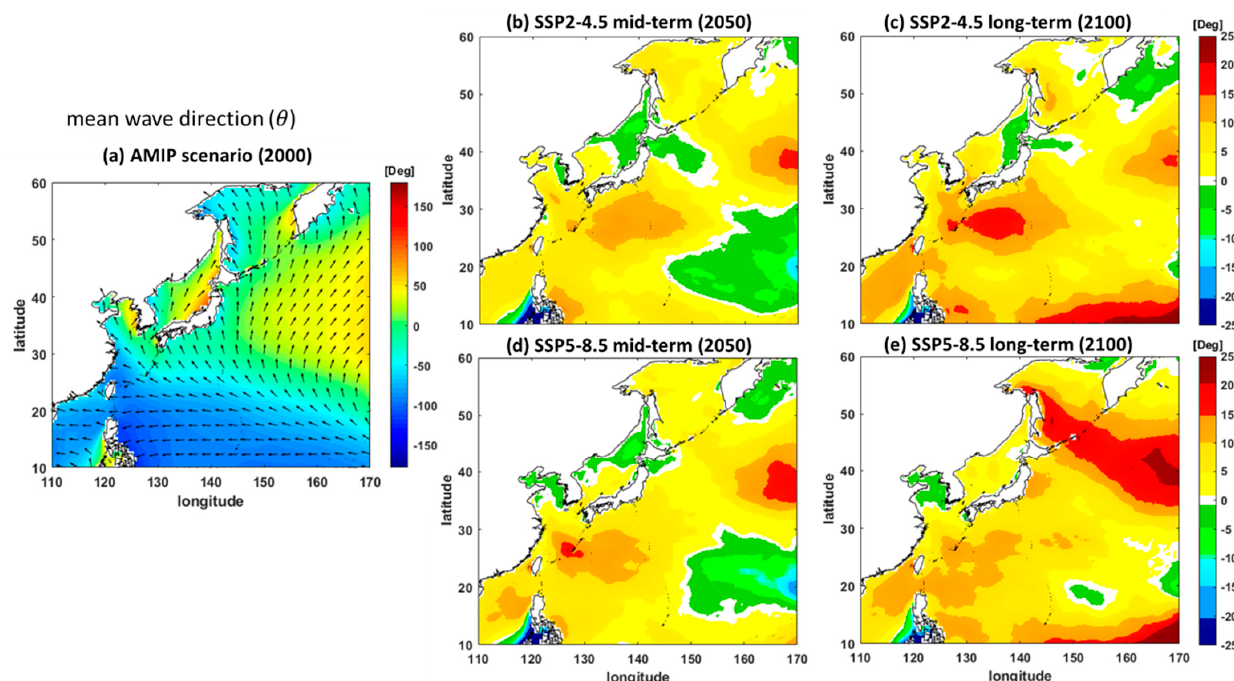
Figure 4 . Mean wave direction ( 𝜃 in degrees) results for ( a ) the AMIP scenario result for 2000 and the differences between the results of future scenarios and the AMIP scenario: ( b ) SSP2-4.5 medium-term, ( c ) SSP2-4.5 long-term, ( d ) SSP5-8.5 medium-term, and ( e ) SSP5-8.5 long-term scenarios.